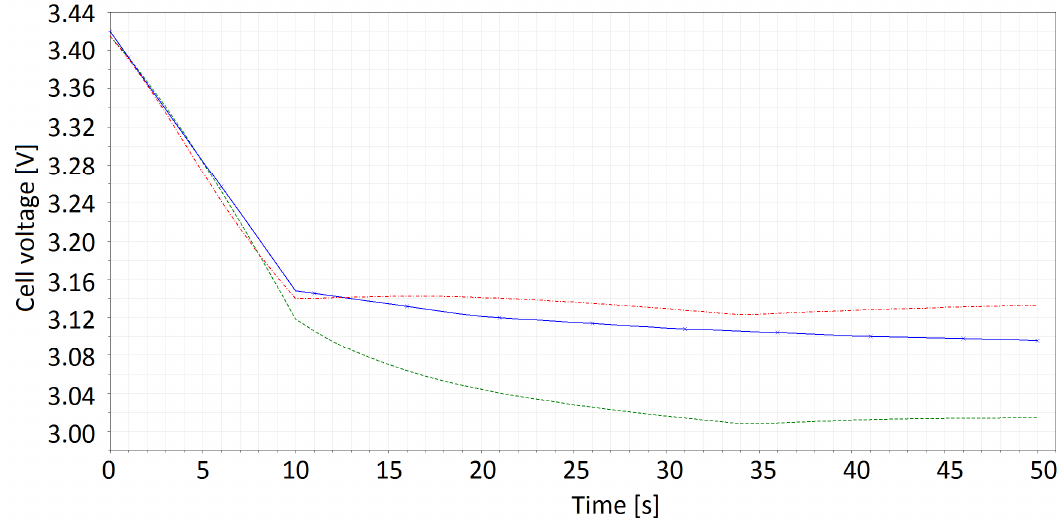
Figure 12. Voltage vs. time for a 20 A·h LFP cell under a 5C (100 A) discharge pulse for 50 s. Solid line (blue) measured laboratory data; dashed (green) model output with no correction; and dashed-dotted (red) model output that includes a current dependent time constant to emulate diffusion